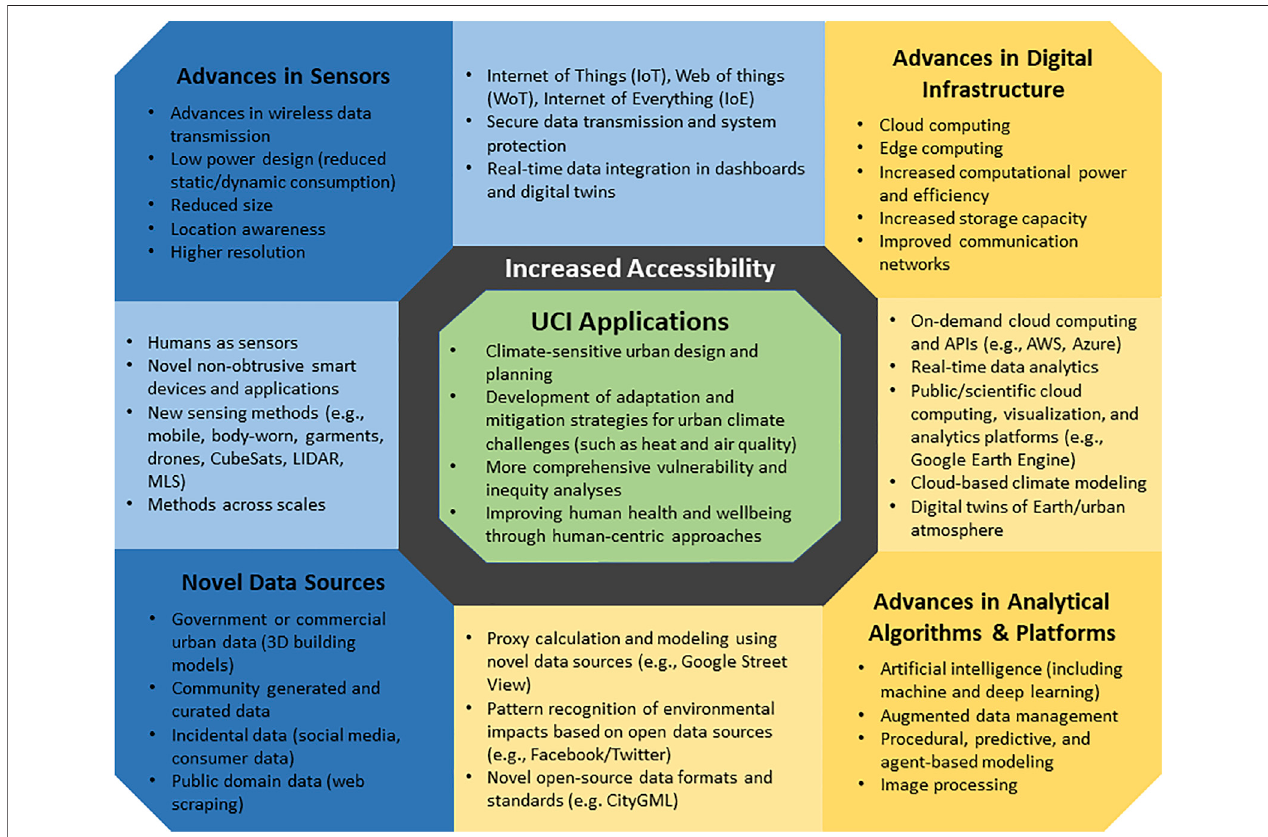
FIGURE 1 | The four cornerstones of Urban Climate Informatics (UCI): Advances in Sensors ( Section 2 ), Novel Data Sources ( Section 2 ), Advances in Digital Infrastructure ( Section 3 ), and Advances in Analytical Algorithms and Platforms ( Section 3 ). Increased accessibility to four pillars enables a wide range of UCI applications